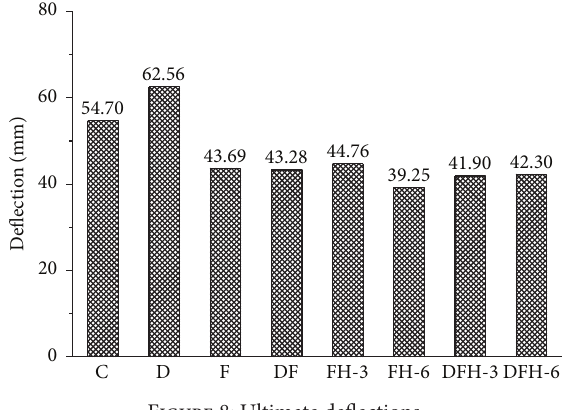
Figure 8: Ultimate deflections.